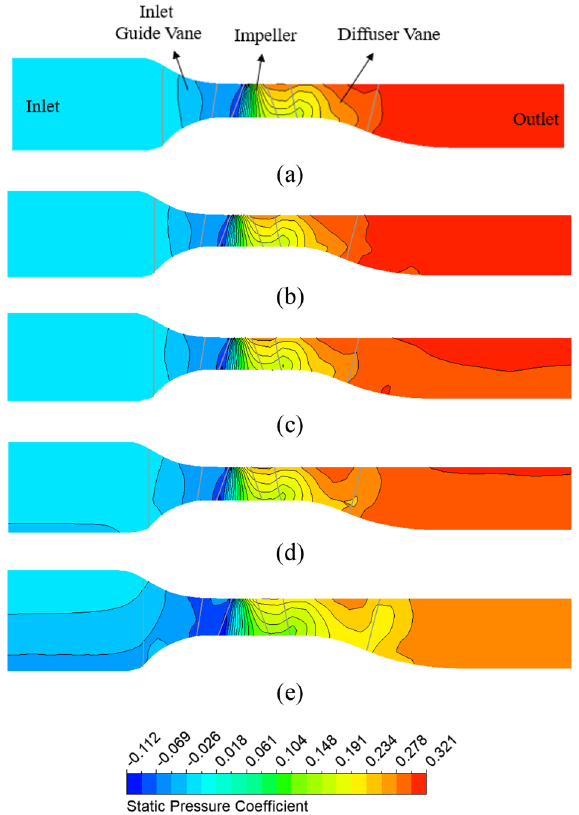
Figure 12. Static pressure distribution at meridional plane in different pre-swirl intensities. ( a ) 0%, ( b ) 5%, ( c ) 10%, ( d ) 15%, and ( e )